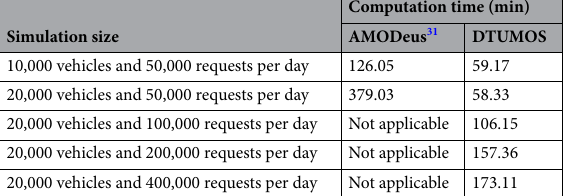
Table 3. Computation time (min) by changing the number of vehicles and requests per day. DTUMOS enables the implementation of extremely large-scale mobility systems at the metropolitan